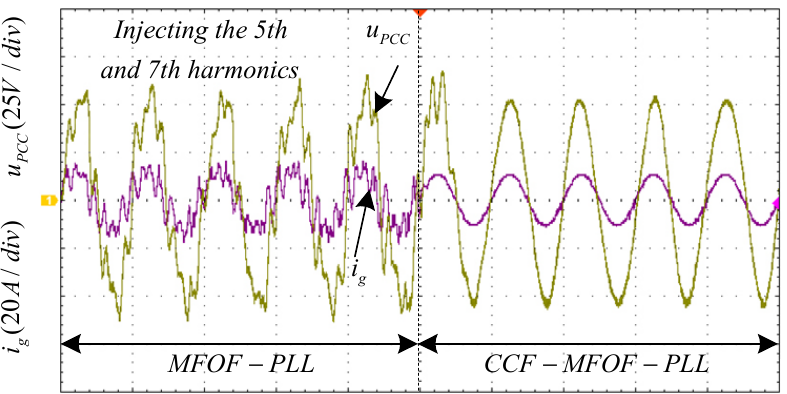
Figure 20. Experimental waveform of current and voltage at PCC after injecting harmonic voltage.